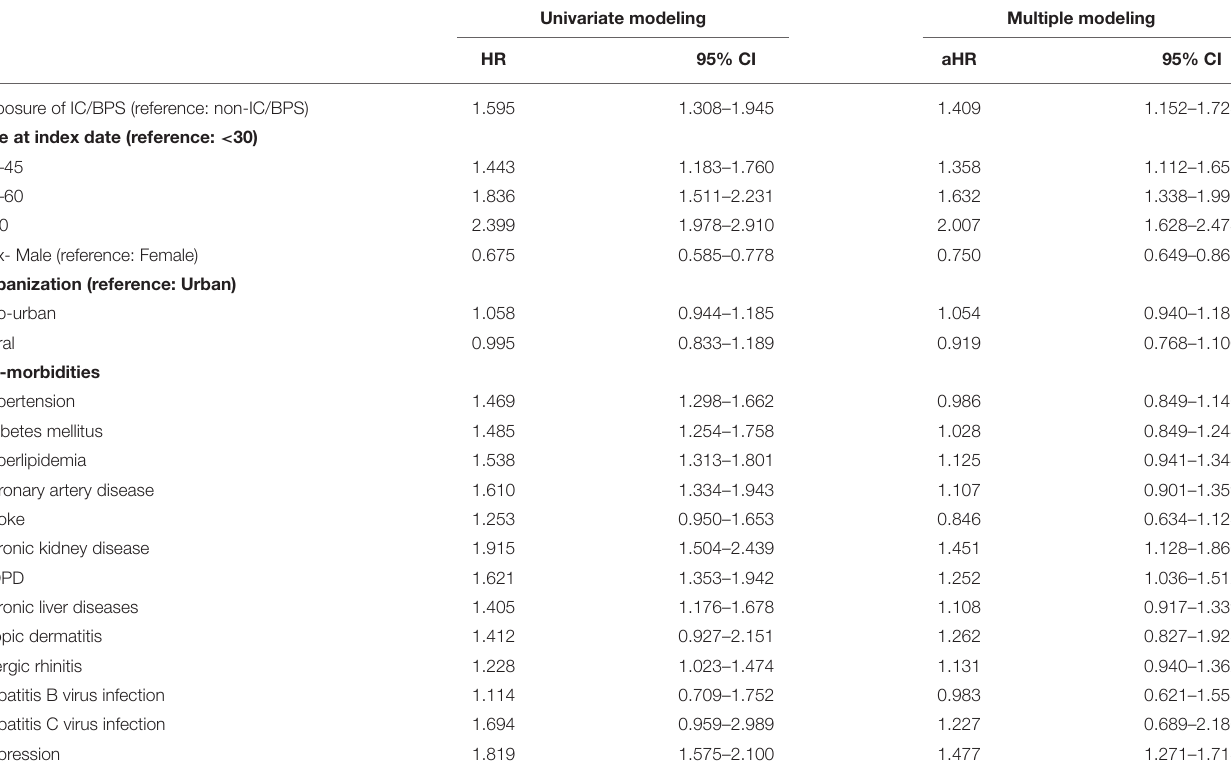
TABLE 3 | Estimation of the hazard ratio of ADs by using Cox proportional hazard regression in age and sex matched